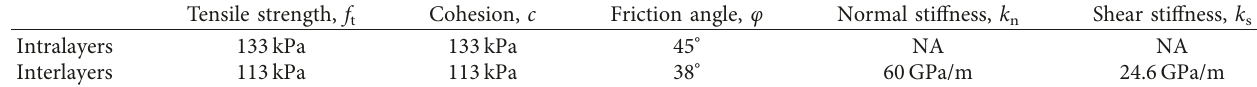
Table 1: Parameters of intralayers and interlayers used in the DEM